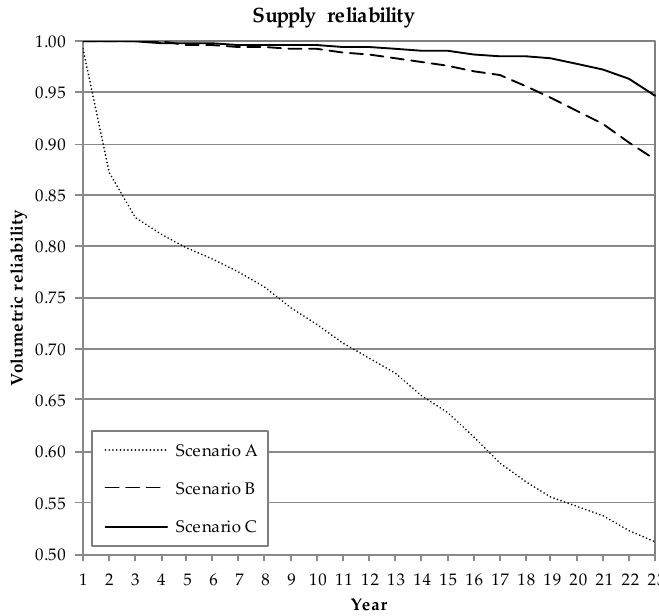
Figure 4. Annual volumetric reliability (mean value) of the supply to Great Gaborone over the simulated period (23 years).